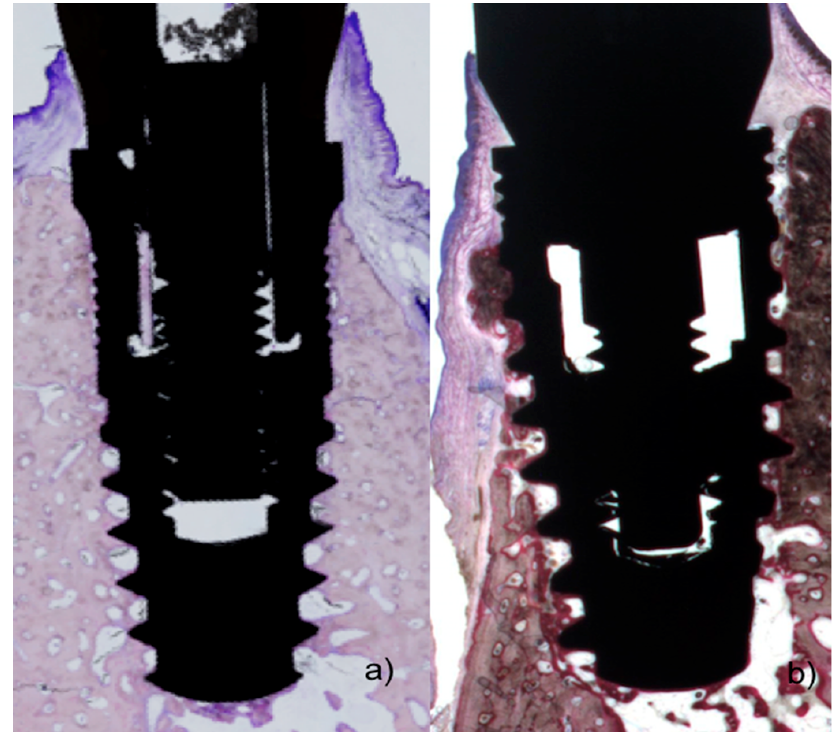
Figure 2. ( a ) Histological preparations representing the outcome after 8 weeks healing showing polished neck and micro-ring neck design of the Blue Sky implant; and ( b ) outcome after eight weeks healing of micro-ring neck design of the C1 implant.